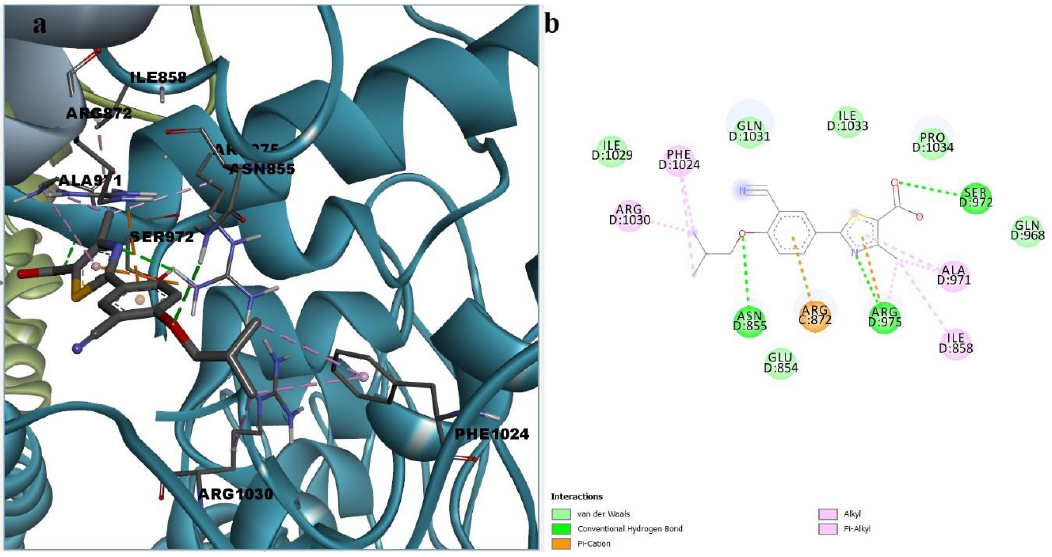
Figure 10. ( a ) 3D binding conformation of febuxostat into putative HC-030031 binding site; ( b ) 2D diagram of protein-ligand interactions between TRPA1 and febuxostat. diagram of protein-ligand interactions between TRPA1 and